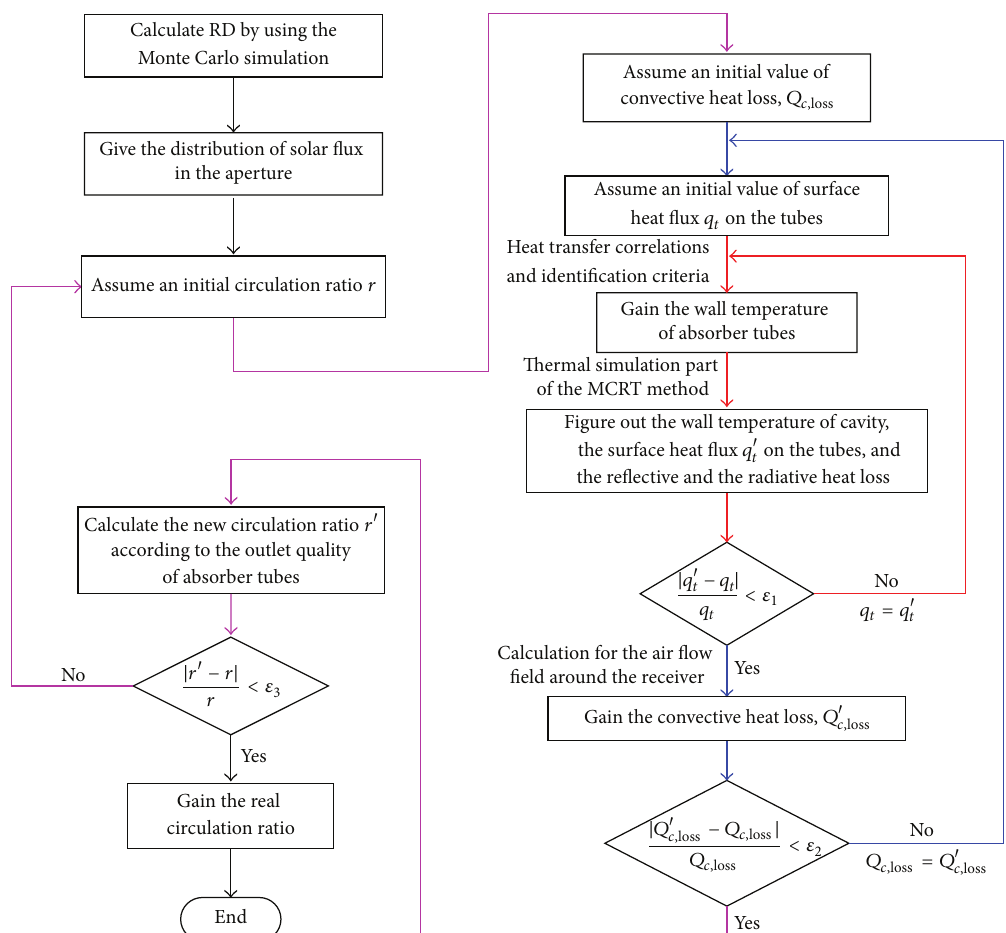
Figure 2: Flow chart for calculating the thermal performance of the solar cavity